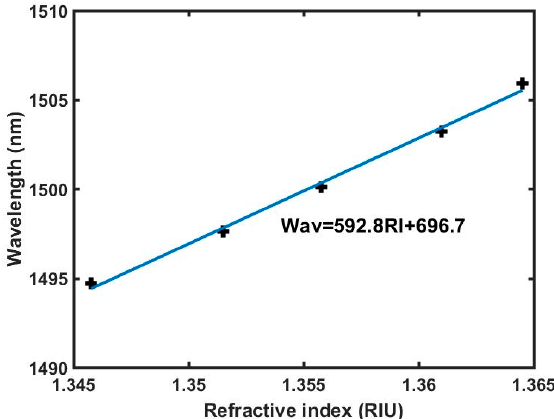
Figure 6. Relationship between the dip wavelength and the refractive index of ethanol solution.